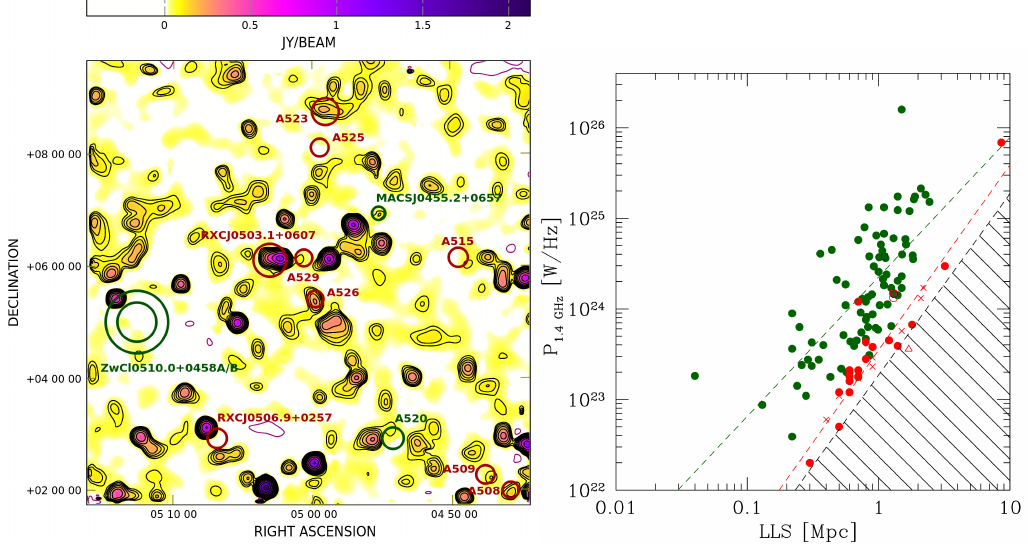
Figure 4. Left : Colors and contours represent the SRT image at 1.4GHz. The contours are − 3 σ (magenta, √ σ = 20mJy/beam), 3 σ and the remaining scale by a factor 2 (black) at a resolution of 13.9 (cid:48) × 12.4 (cid:48) . Circles and labels identify galaxy clusters in the field with known redshift, with size of the circles proportional to the distance of the cluster (large circles are close-by clusters, while small circles are distance clusters), in red for 0.08 < z < 0.15, in green outside this range. Right : Radio power P 1.4GHz versus the largest linear size LLS at 1.4 GHz. Measurements from literature are represented by green dots and blue open symbols, while red symbols are the new data presented in [40]. The shaded area represents the inaccessible region at our sensitivity. Dashed green and red lines represent respectively the linear fit in logarithmic scale for cluster sources and for the new sources. These images have been produced in the context of the work